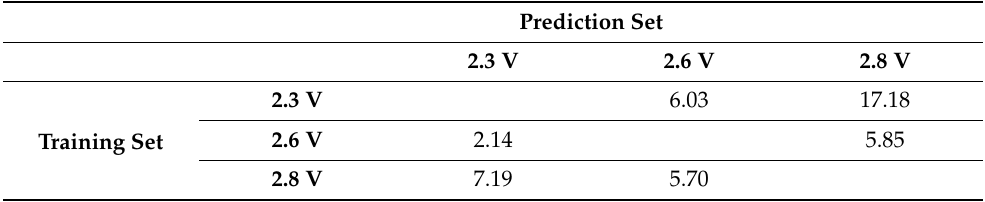
Figure A3. Scatter plots comparing the predictions of the ANN model trained on transient PCM temperature data for different training/prediction dataset combinations. Table A1. Percentage error in prediction at τ ’ = 0.5 (actual) for different training/prediction data-set combinations from ANN using transient PCM-temperature